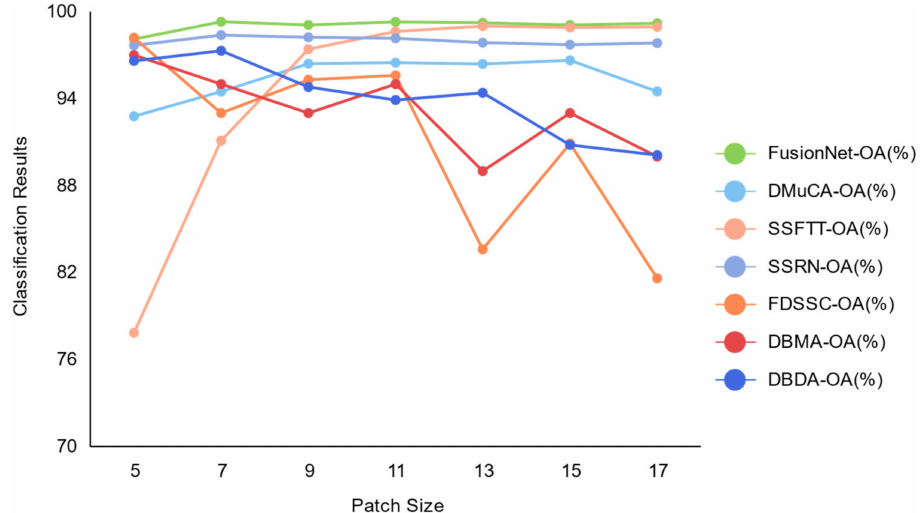
Figure 15. Effect of patch size on classification